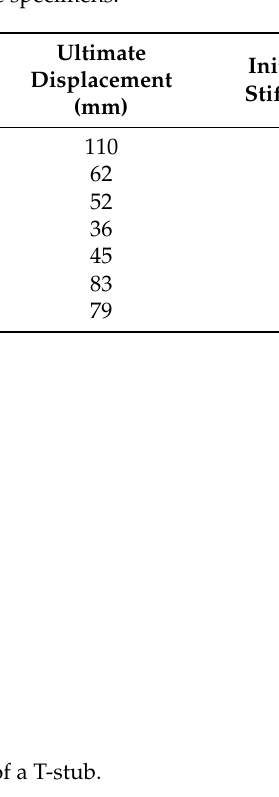
Figure 8. Force–displacement test curves for T-stubs. Table 5. Mechanical properties parameters of test T-type specimens.